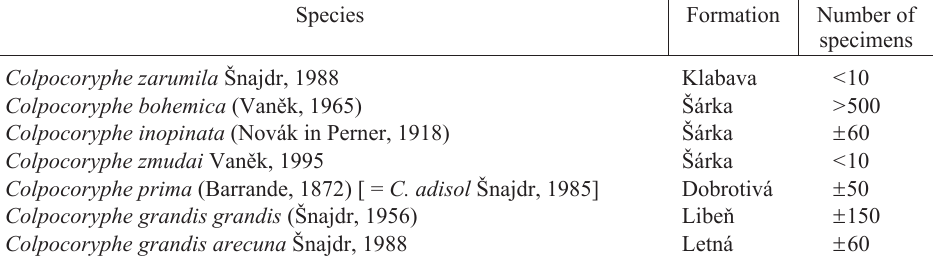
Table 1. Species of the genus Colpocoryphe Novák in Perner, 1918 in the Ordovician of the Prague Basin